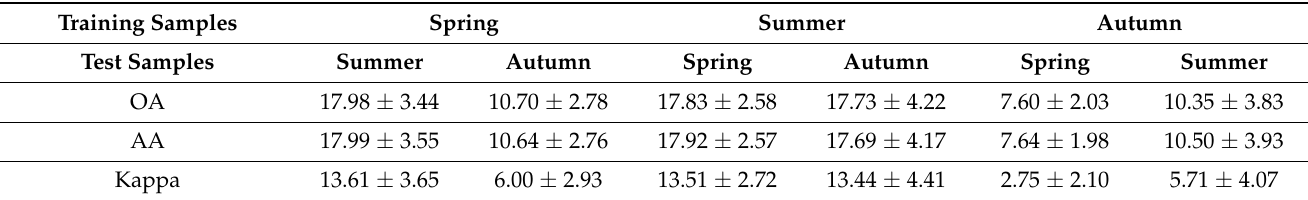
Table 3. Accuracy (%) of single season samples classifying other season samples.